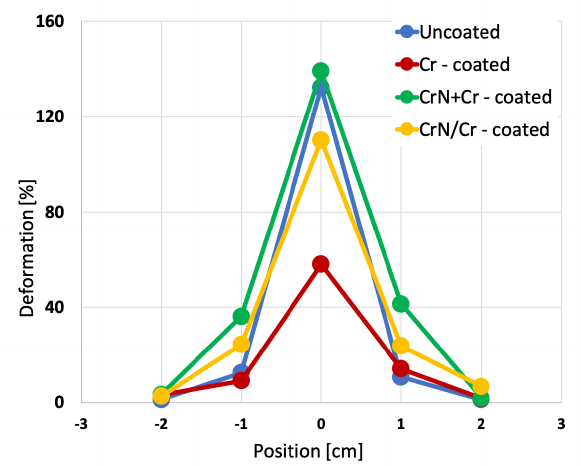
Figure 8. Deformation at temperature 800 ◦ C under inner pressure of 10 MPa in relation to position for different types of coatings and uncoated specimens